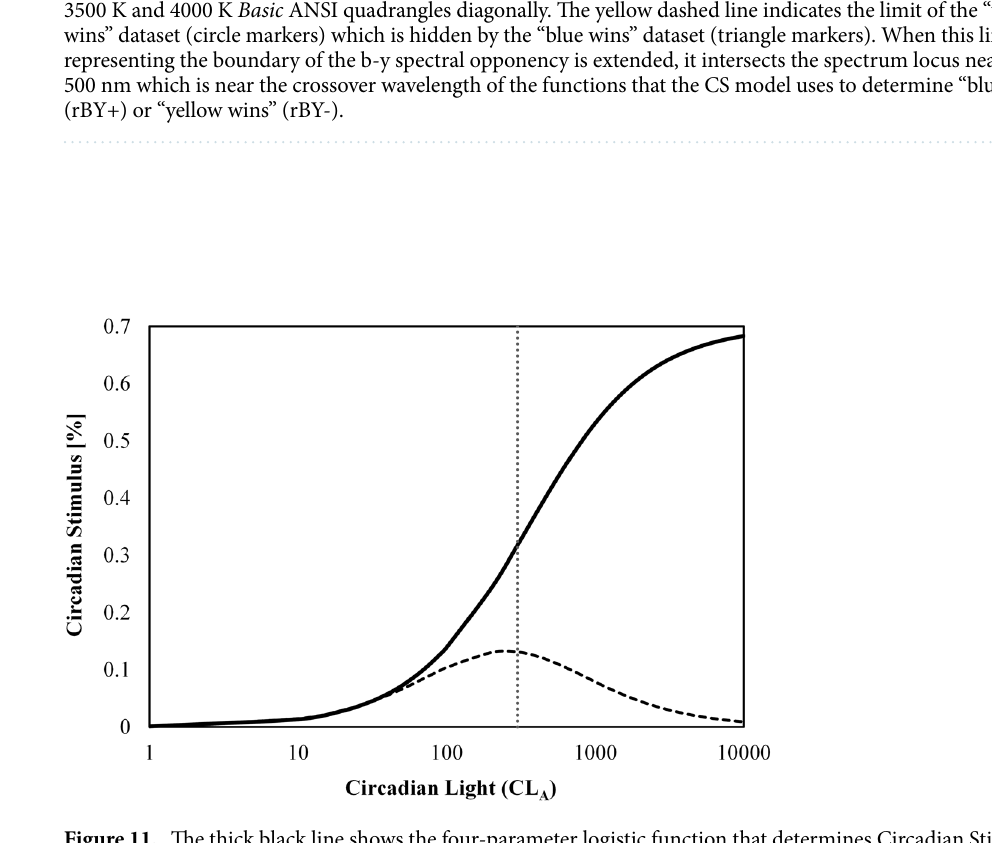
Figure 11. The thick black line shows the four-parameter logistic function that determines Circadian Stimulus (CS) from Circadian Light (CL A ). The dashed curve indicates the difference in CS when CL A is doubled. This can be thought of the “strength” of doubling CL A on CS at the specified CL A value. The vertical dashed line indicates that the largest increase on CS of doubling CL A occurs at a CL A of 300 (near the inflection point of the logistic function), which can be for a photopic illuminance of 300–500 lx, depending on